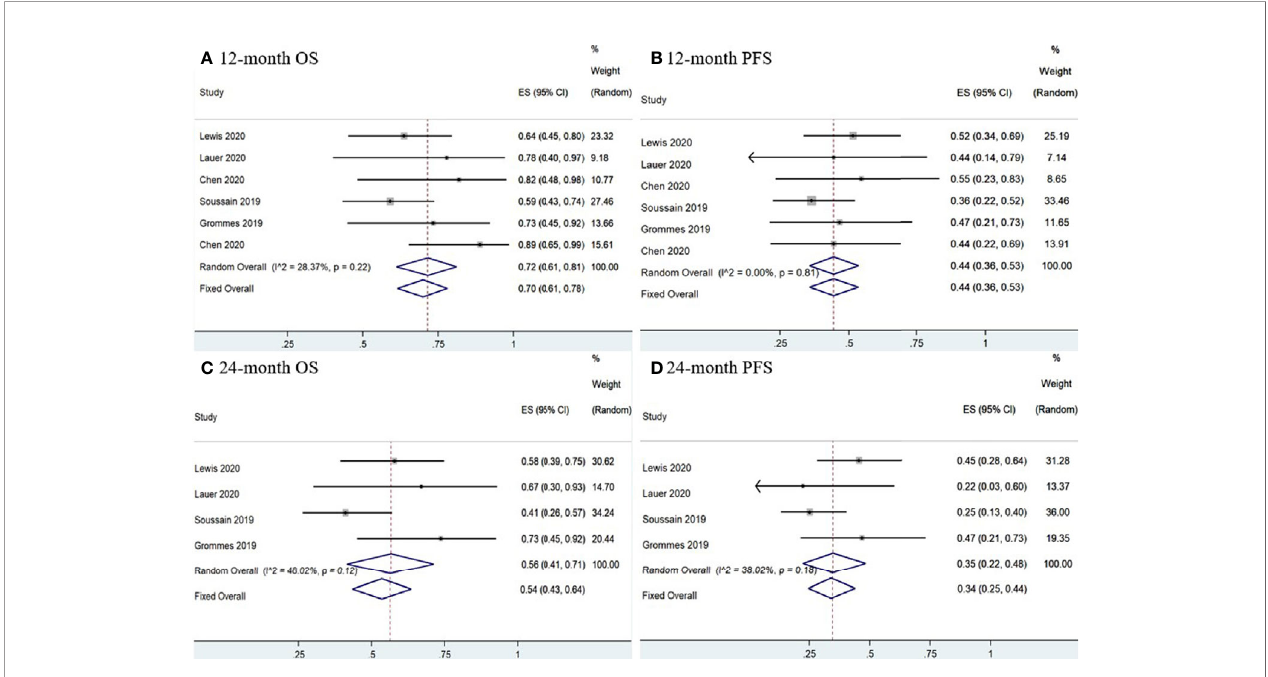
FIGURE 10 | Survival of central nervous system lymphoma. (A) 12-mouth overall survival. (B) 12-mouth progression-free survival. (C) 24-mouth overall survival. (D) 24-month progression-free survival.